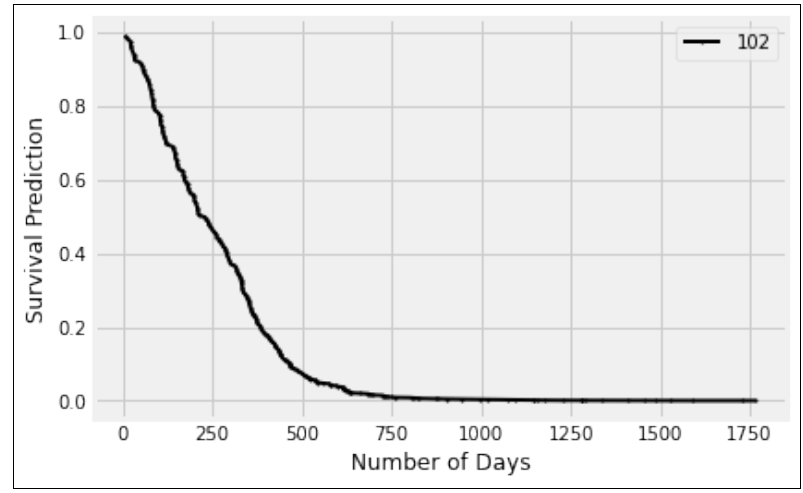
Figure 9. Single patient survival rate.